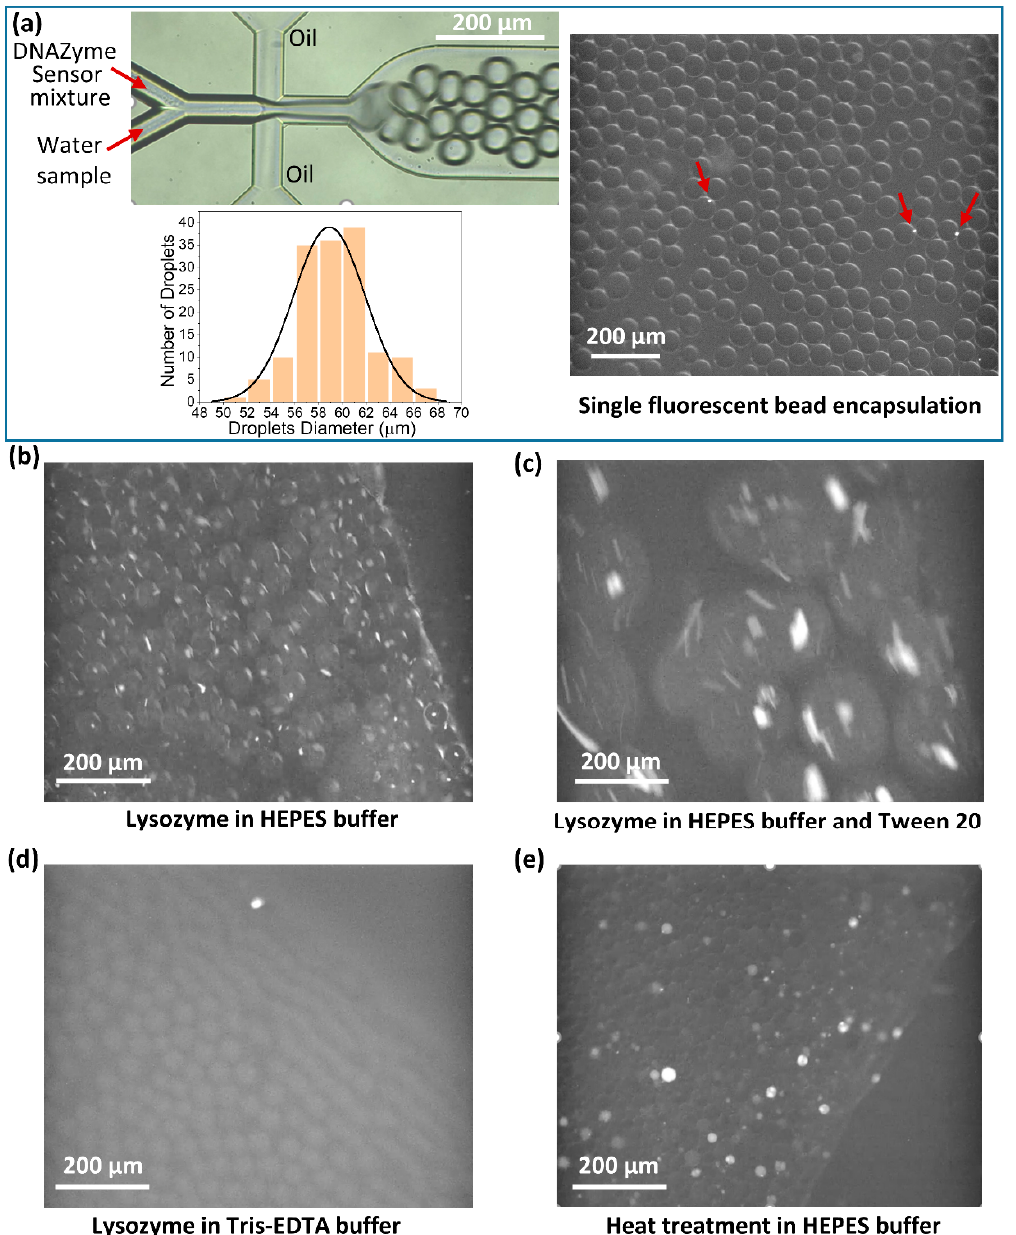
Figure 2. ( a ) Production of water droplets using the microfluidic device and encapsulation of fluorescent beads into the droplets. ( b – d ) Lysozyme (1 mg/mL) used in different buffer systems for bacterial cell lysis. ( e ) Cell lysis in HEPES buffer due to heat treatment at 105 °C.